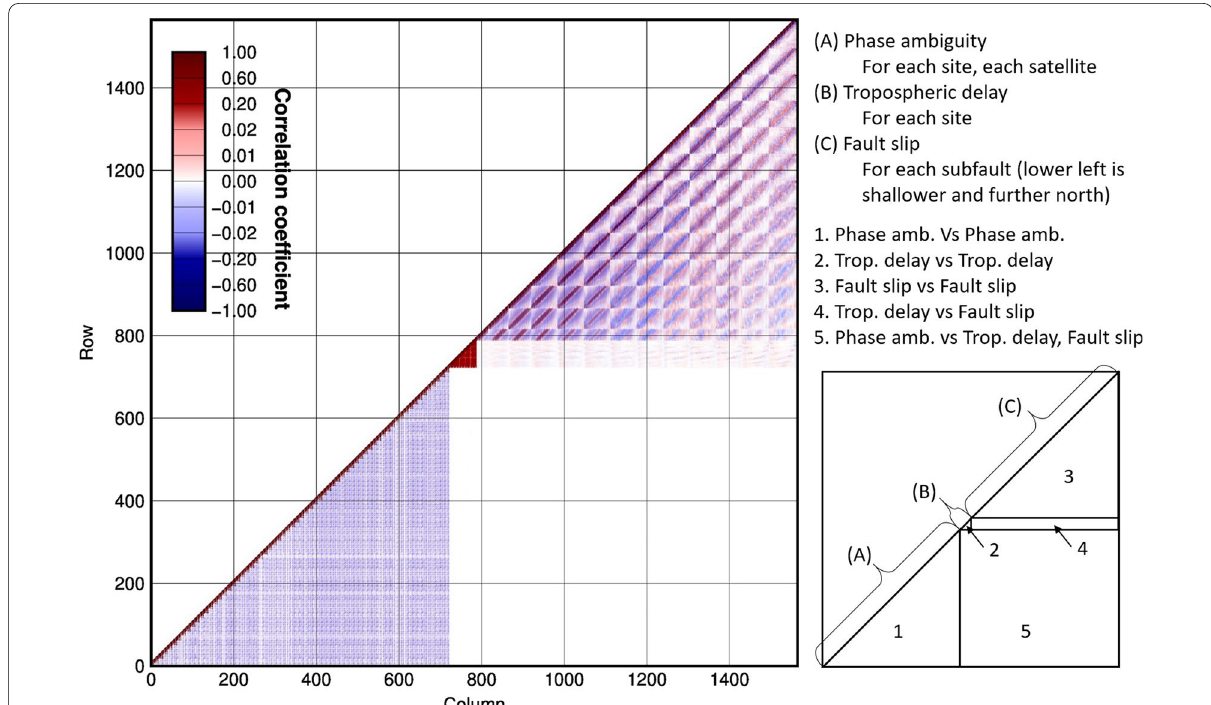
Fig. 10 Correlation coefficient matrix at 05:40 estimated by Kalman filtering. The figure describes the values of each component directly with the color scale. The X-axis corresponds to the column direction, while the Y-axis corresponds to the row direction, respectively. The structure of the matrix is displayed on the right side. The fault slip part is lined up from shallower to deeper and north to south. The repeating pattern and smaller grid structure in region 3 is visible. Each grid corresponds to each row of subfaults along strike. The grid on the lower left side indicates a shallower row. The lower left side in each grid indicates the further north part of that